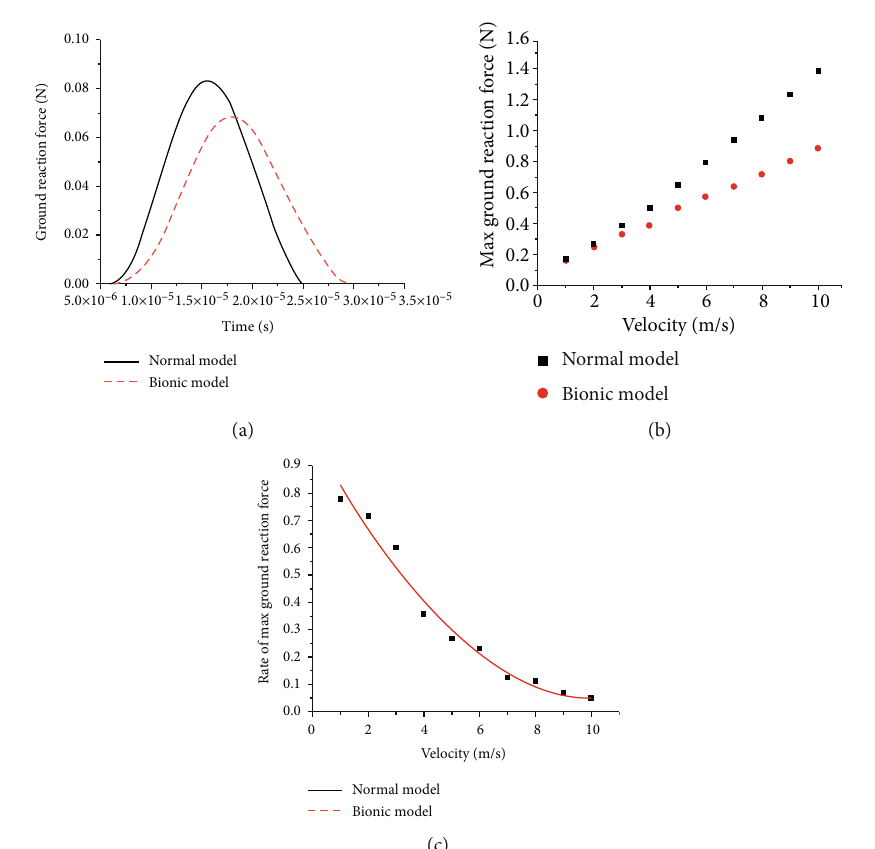
Figure 7: (a) Ground reactions from the bionic model and the normal model when the top plates were loaded with the velocity of 1 m/s; (b) peak ground reactions from the two models under the loaded velocity of 1 to 10 m/s; (c) ratio of reaction peak of the bionic model to the normal model under the loaded velocity of 1 to